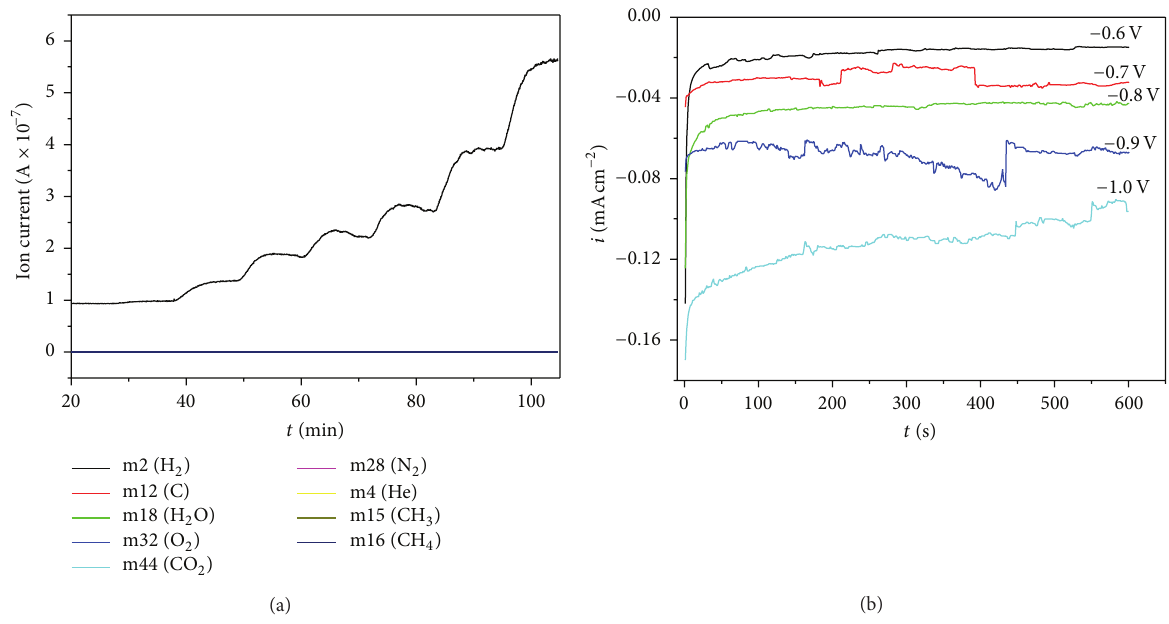
Figure 6: (a) MS diagram; (b) chronoamperograms obtained at different applied potentials with Pd-Au/carbon felt electrode.